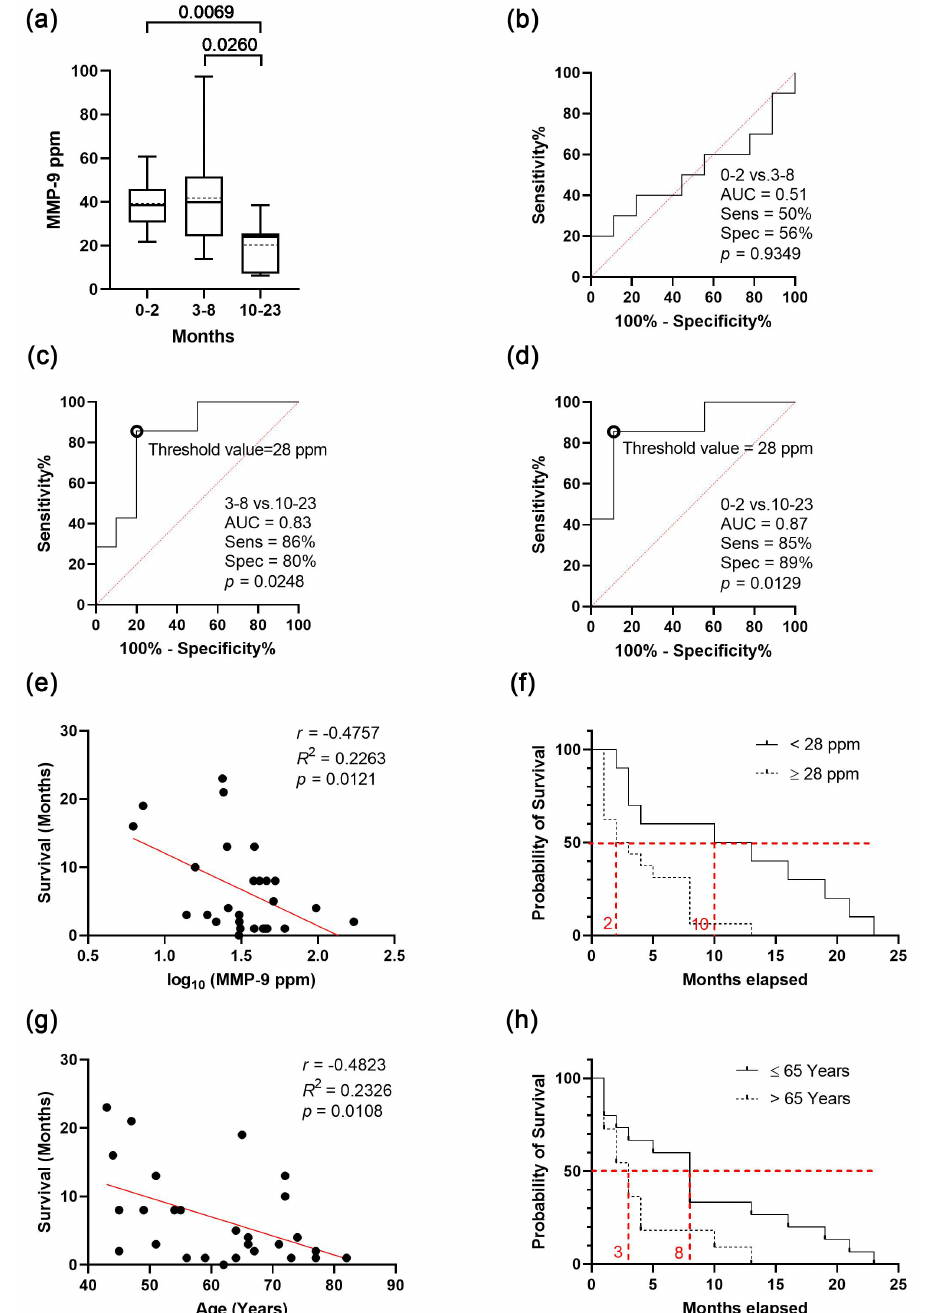
Figure 4. Investigation of survival in GBM patients . ( a ) Differences among the short-, medium- and long-term survival based on MMP-9 level of serum derived sEVs of GBM patients (median with interquartile range, mean with dotted line, error bars range from the 5th–95th percentiles, dotted lines indicate mean values). ( b – d ) Receiver operating characteristic (ROC) curves for comparing the short- (0–2 months), medium- (3–8 months) and long-term (10–23 months) survival groups (threshold values of the group-membership score are marked with black circles). ( e ) Correlation between MMP-9 level and survival in the GBM group (nGBM = 27). ( f ) Overall survival according to low and high ( n < 28 ppm = 10 and n ≥ 28 ppm = 17) MMP-9 level. ( g ) Relationship between age and survival in the GBM group (nGBM = 27); ( h ) Overall survival according to the age ( n ≤ 65 years = 16 and n > 65 years =